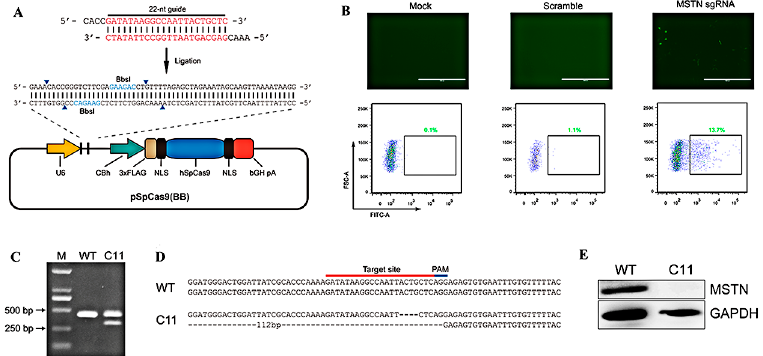
Figure 1. Preparation and validation of knockout (KO) cells. ( A ) Schematic of the recombinant plasmid. The plasmid was designed with the enzyme restriction sites after the U6 promoter. ( B ) Fluorescence microscopy images of cells. From left to right: mock group, scramble group and myostatin (MSTN) sgRNA group (scale bar = 1000 µ m). ( C ) Electrophoretogram of the results of cell validation by PCR. ( D ) Wild-type (WT) and C11 sequences. C11 cells have a deleted section due to the sgRNA. ( E ) Identification of MSTN protein levels in WT and C11 cells by Western blot analysis. There was no MSTN protein expression in C11